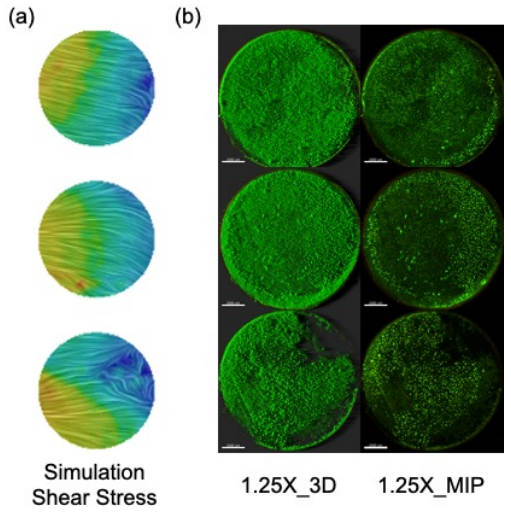
Figure 10. A visual comparison of the ( a ) instantaneous wall shear stress in the simulated reactor and ( b ) lab-grown Pseudomonas aeruginosa. Images were collected using an upright Leica TCS-SP5 Confocal Scanning Laser Microscope and an extra-long 1.25× water immersion objective. The three- dimensional blend images are a three-dimensional representation, including shadowing. The max- imum intensity projection (MIP) images show the maximum intensity for all layers of the z-stack. Biofilm grown by Kelli Buckingham-Meyer and Lindsey Miller. Imaging by Lindsey